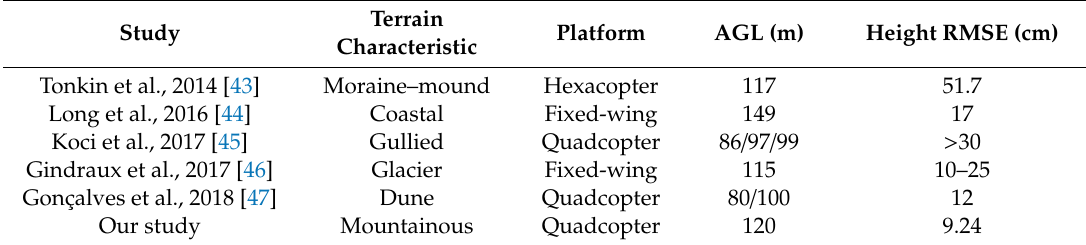
Table 3. Comparative table of height accuracies among UAV-based topographic surveys under complex terrain conditions. UAV: unmanned aerial vehicle; AGL: above the ground level; RMSE: root mean square error. Terrain Study Platform AGL (m) Height RMSE Characteristic